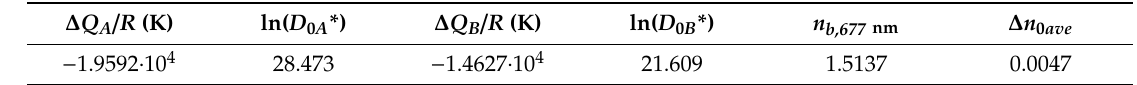
Table 2. Di ff usion coe ffi